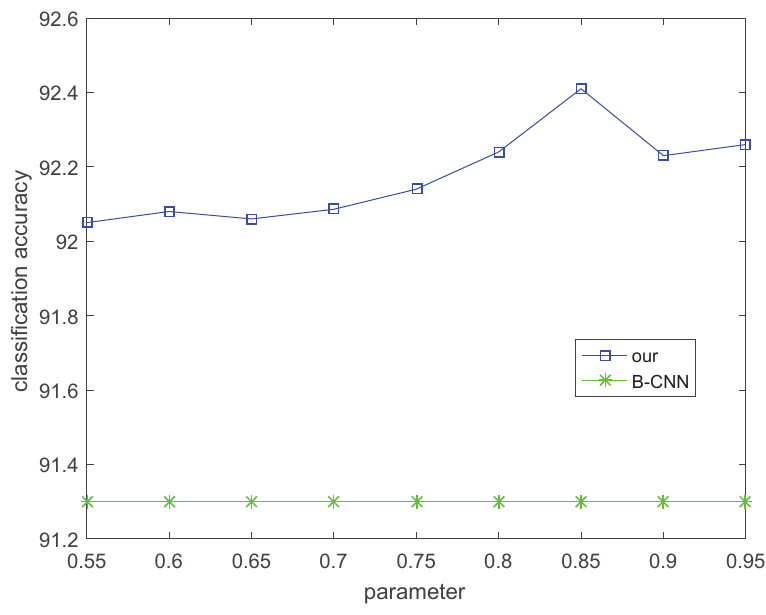
Figure 8. Performance of different α